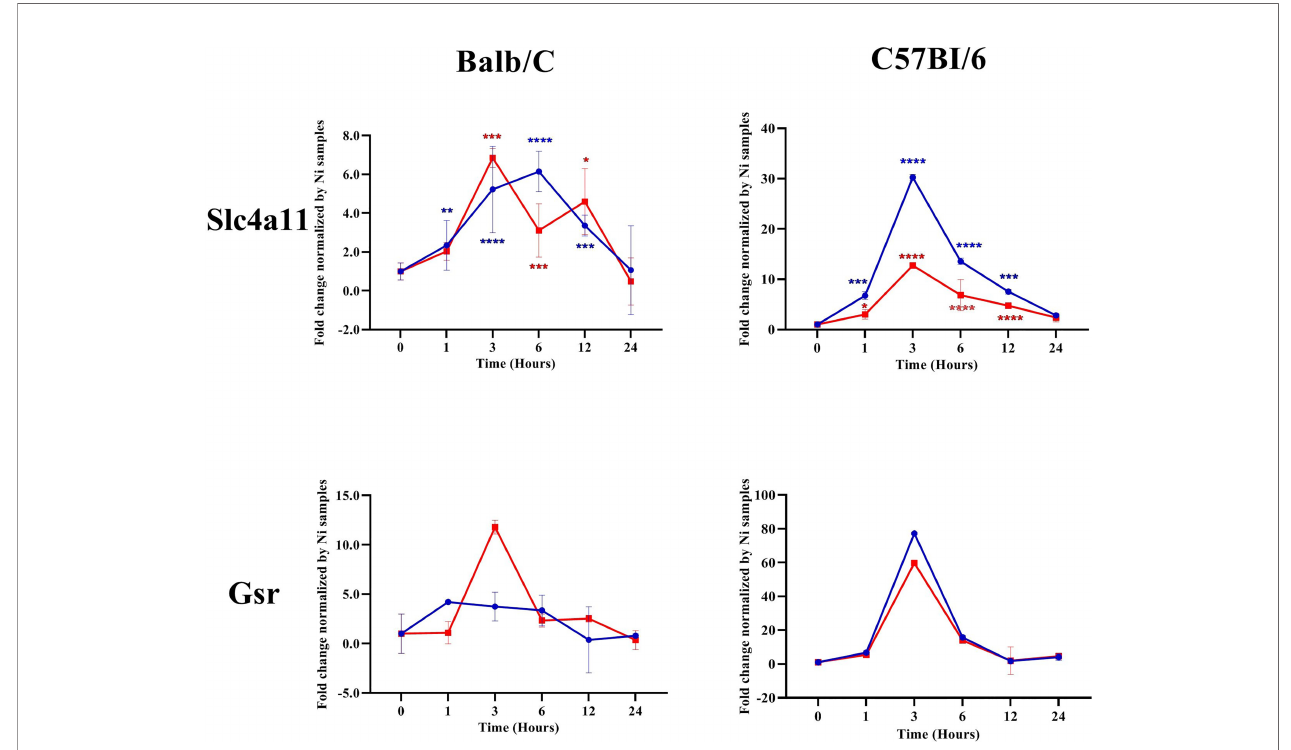
FIGURE 6 | Slc7a11 and Gsr were differentially regulated by Leishmania parasites in Balb/c and C57Bl6 bone marrow-derived macrophages (BMdMs). Balb/c and C57Bl6 BMdMs were infected by live parasites ( P ) ( blue fi lled circle ) or heat-inactivated ( Kp ) ( red fi lled square ) L. major promastigotes for different times. RT-PCR targeting Slc7a11 and Gsr was performed. The graphs show fold change results expressed as the mean ± SD from three independent experiments. * p < 0.05, ** p < 0.01, *** p < 0.001, **** p < 0.0001 vs . non-stimulated BMdMs (two-way ANOVA).